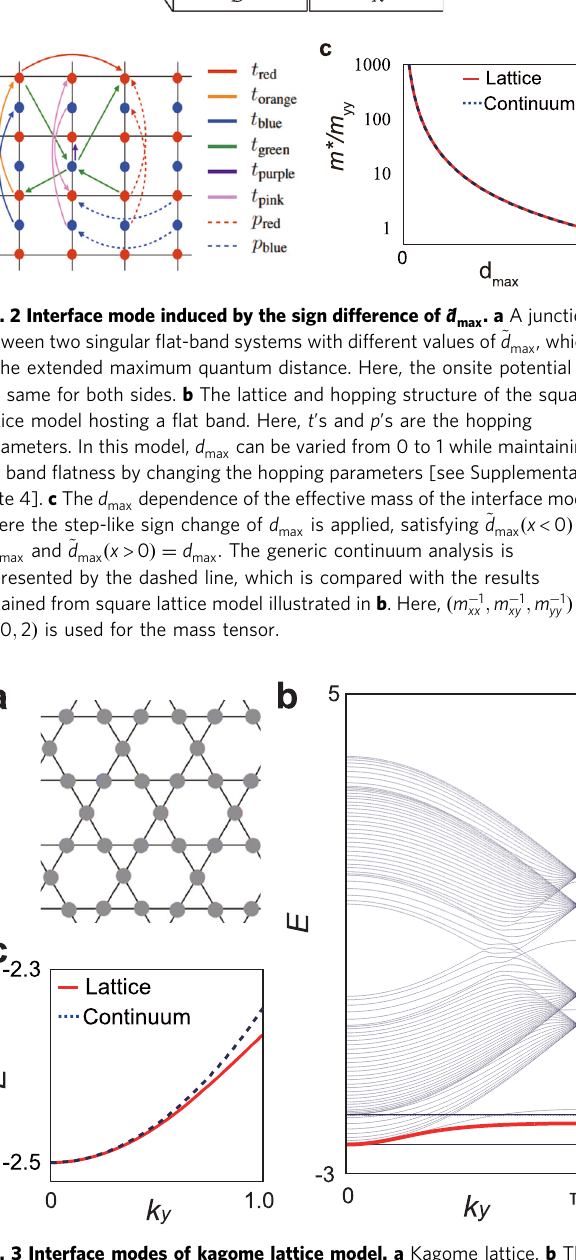
Fig. 3 Interface modes of kagome lattice model. a Kagome lattice. b The band structure of the kagome lattice model, where the step-like interface potential U ( x ) satisfying U ( x < 0) = − 2 and U ( x > 0) = − 2.5 is applied. The red curve represents the interface states. The other edge bands are from open boundaries. c The interface band in b is highlighted and compared with the continuum result (5) with d max ¼ 1 and m (cid:2) 1 m (cid:2) 1 = 2, m (cid:2) 1 xx ¼ yy ¼ 1 xy ¼ 0 (dashed line). square lattice model. To investigate the interface modes, we create an interface by applying a step-like potential U ( x ) = U step ( x ) along x -axis such that U step ( x ) = 0 and U step ( x ) = U 0 when x < 0 and x > 0, respectively. We apply an open boundary condition at the left and right ends of the system.